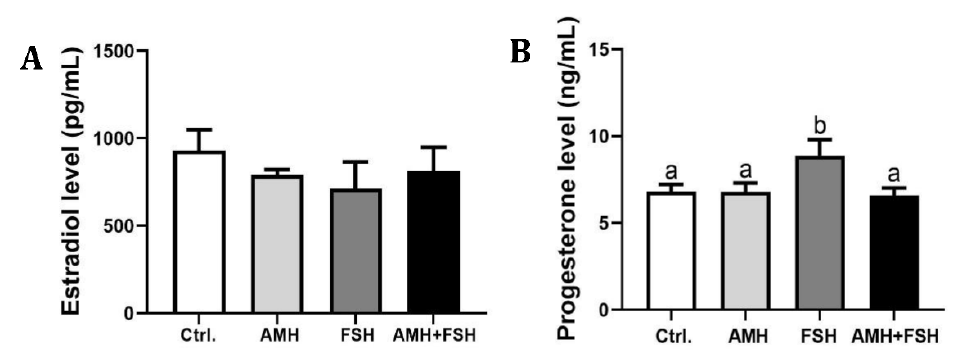
Figure 5. Effect of rhAMH treatment on estradiol ( A ) and progesterone ( B ) productions in COCs. The data were expressed as mean ± SEM from three independent experiments. Bars with different letters represent significant differences ( p < 0.05).